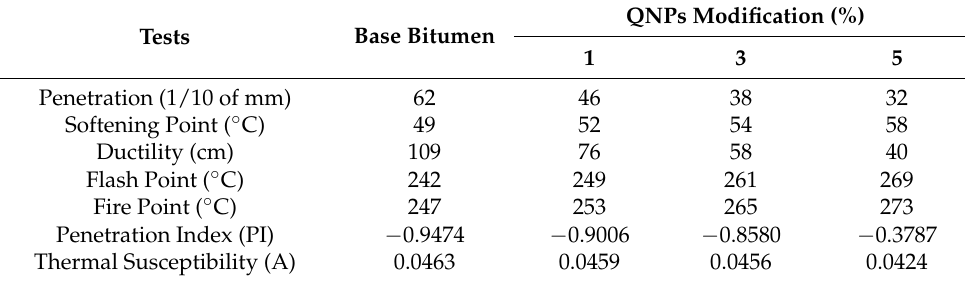
Table 5. Conventional test results of base bitumen and QNP modification.